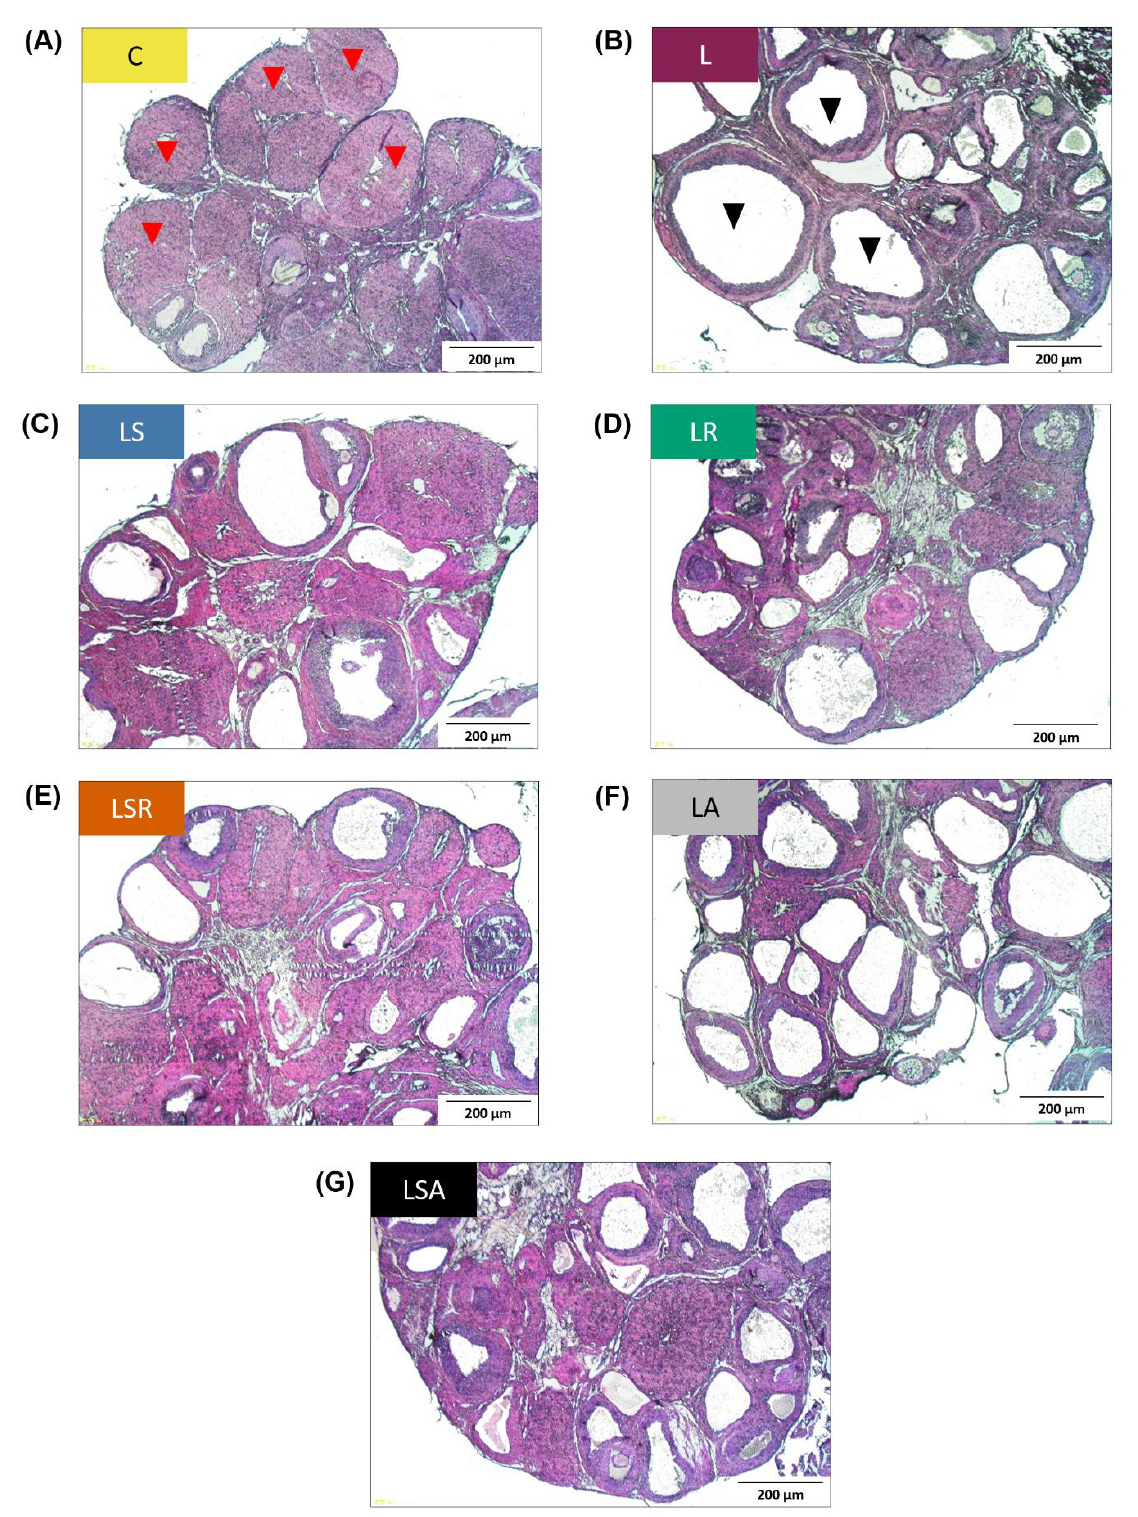
Figure 3. Photomicrographs of ovarian sections of a representative rat from each study group. Excised ovaries were embedded in paraffin blocks, and the sections were stained using hematoxylin–eosin stain. ( A ) C group, ( B ) L group, ( C ) LS group, ( D ) LR group, ( E ) LSR group, ( F ) LA group, ( G ) LSA group. Red arrowheads = corpora lutea; black arrowheads = cystic follicles; scale bars = 200 μm .